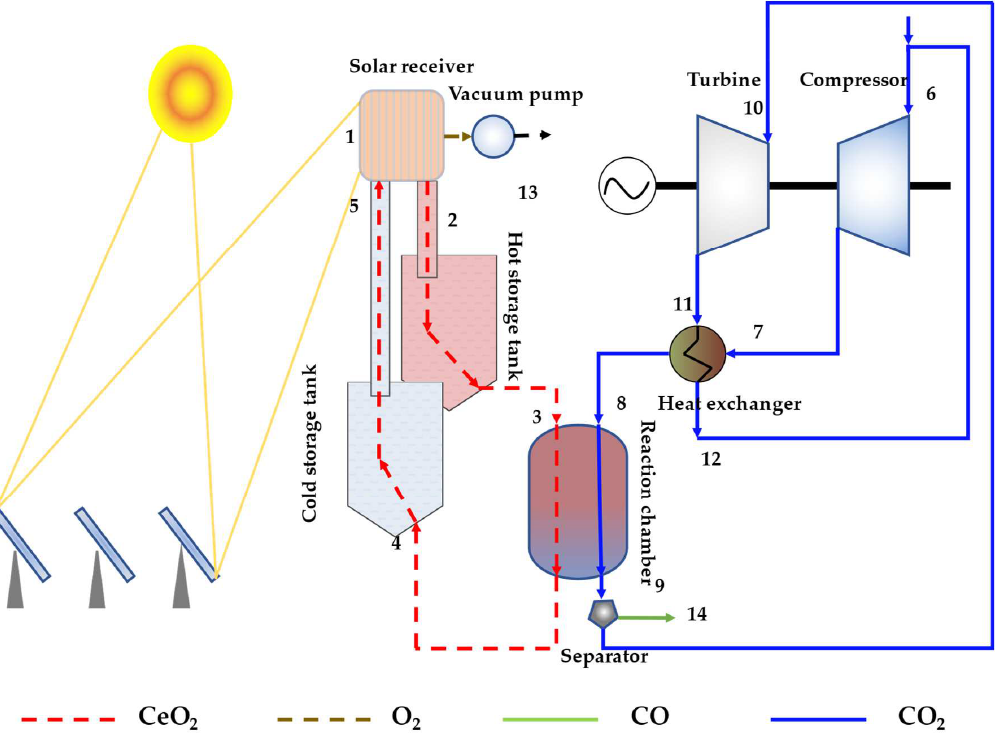
Figure 1. Schematic diagram of ceria-based solar thermochemical CO 2 splitting system integrated with a supercritical CO 2 Brayton cycle.